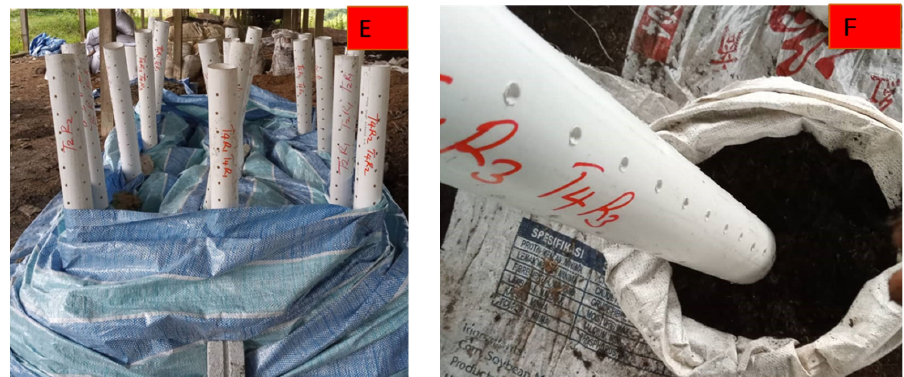
Figure 1. Some of the materials used and bokashi fertilizer undergoing decomposition process. ( A ) Horse bedding waste and paddy husk charcoal. ( B ) Cow dung as the major source of nutrients. ( C ) Molasses and EM4. The molasses provides the needed energy to the microbial inoculum (EM4). ( D ) The 3 L container used to measure the raw materials. One full container = 10% of any of the solid raw materials used. That is, 100% of each bfr treatment was comprised of 10 full measures of the 3 L measuring container (shown in ( D )). Therefore, for bfr1, we used an 8 + 0 + 2 measuring container with HBW + CD + PHC, respectively. For bfr2, it was an 8 + 1 + 1 measuring container with HBW + CD + PHC, respectively. For bfr3, it was a 7 + 2 + 1 measuring container with HBW + CD + PHC, respectively. For bfr4, it was a 7 + 1 + 2 measuring container with HBW + CD + PHC, respectively. For bfr5, it was a 6 + 2 + 2 measuring container with HBW + CD + PHC, respectively. For bfr6, it was a 6 + 2.5 + 1.5 measuring container with HBW + CD + PHC, respectively ( E ). Bokashi fertilizer on day four of the experiment, undergoing semi ‐ anaerobic decomposition with 3” PVC pipes, 1 m long each, vertically inserted into the double ‐ bag sacks containing the mixture and providing the aeration needed at this stage of decomposition. ( F ) Bokashi fertilizer at the end of time 1 (seven days’ maturation). bokashi maturation is given in Figure 2.